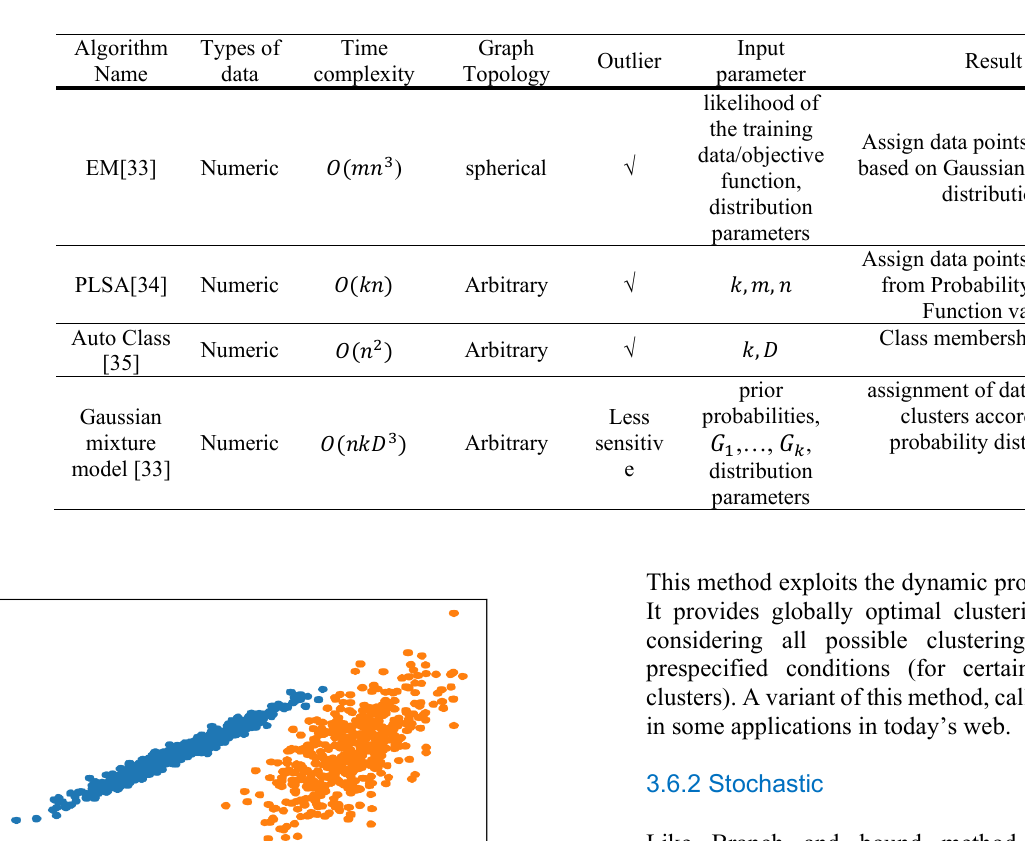
Table 5. Characteristics of common Probabilistic Clustering Algorithms